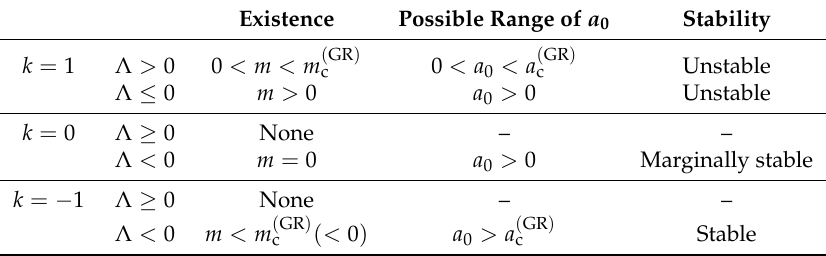
Table 5. The existence and stability of Z 2 symmetric static thin-shell wormholes made of pure negative ( GR ) ( GR ) tension in Einstein gravity, where a c and m c are defined by Equations (135) and (136), respectively. Existence Possible Range of a 0